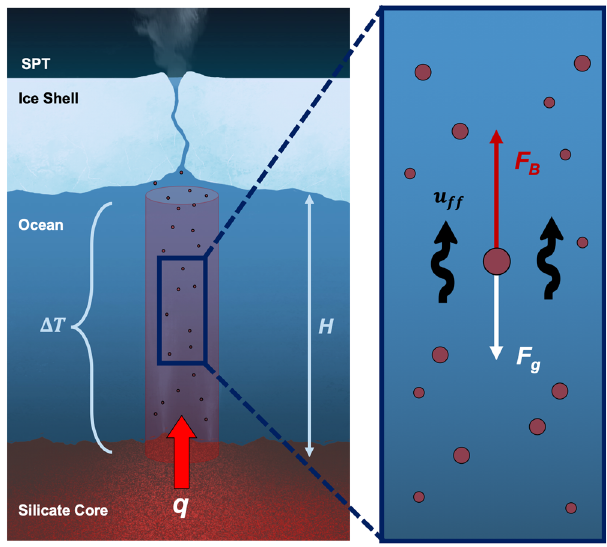
Fig. 4 Particle entrainment in Enceladus ’ ocean. Conceptual diagram of a columnar vortex entraining particles in Enceladus ’ ocean (left). Conceptual diagram illustrating the force balance on an entrained silica particle that is traveling vertically upward at velocity u ff